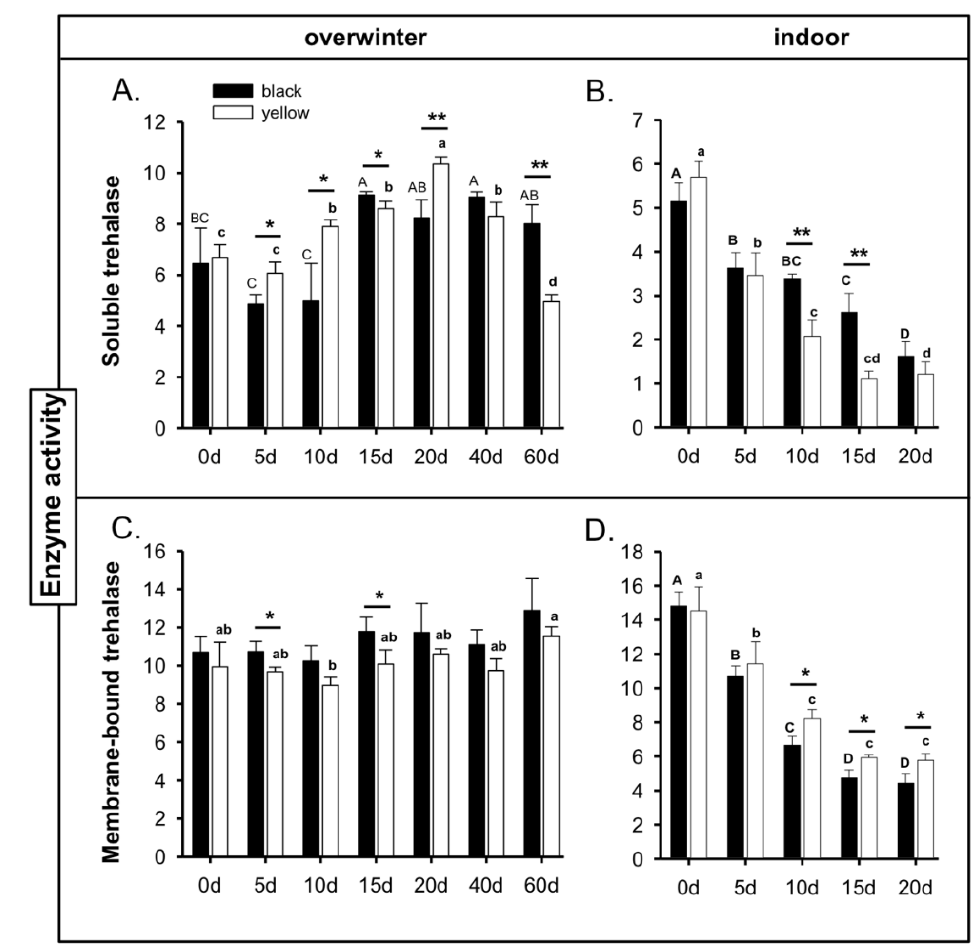
Figure 3. Changes in two trehalase enzymes in H. axyridis yellow (non-melanic) and black (melanic) adults in the overwinter and experimental (indoor) populations under different cold storage periods (0–60 days and 0–20 days, respectively). ( A , B ) Changes of TRE1 during cold storage in overwinter and experimental (indoor) H. axyridis populations. ( C , D ) Changes of TRE2 during cold storage in overwinter and experimental (indoor) H. axyridis populations. Bars represent the mean (+SD) of three replicate experiments. The trehalase activity at 0 d cold storage was used as the control group. Bars with different letters indicate significant differences (one-way ANOVA, p ≤ 0.05). Asterisks indicate significant differences between yellow and black adults in the same storage period ( t -test, ** p ≤ 0.01; * p ≤ 0.05).